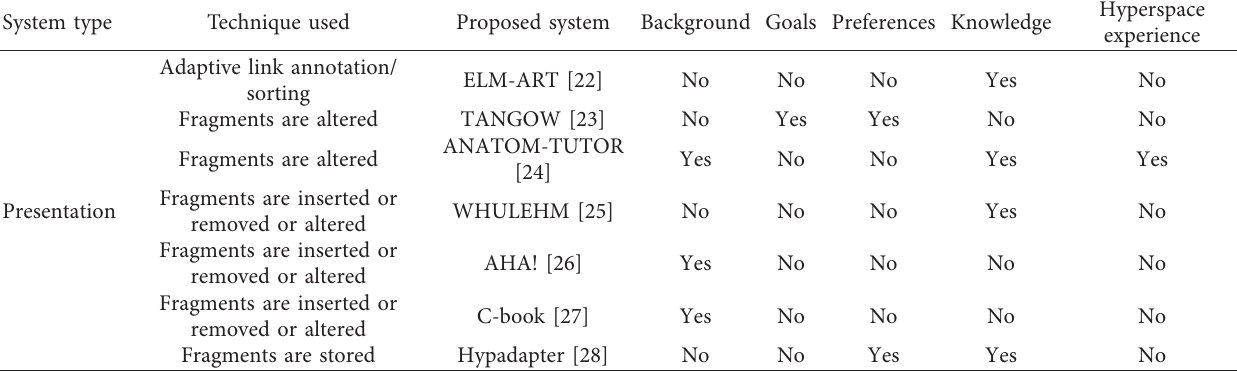
Table 1: Several adaptive presentation systems in the adaptive hypermedia domain.